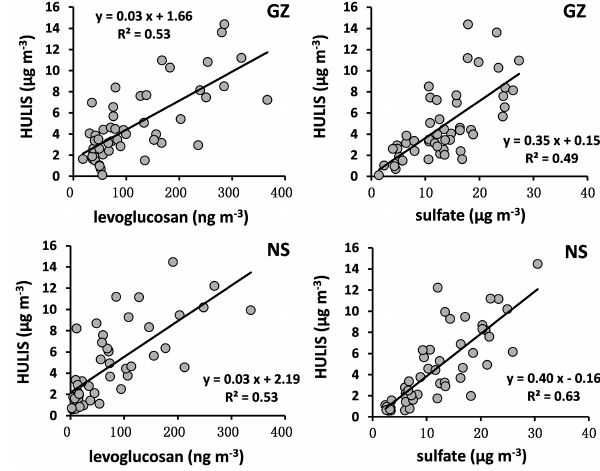
Figure 4. Correlation of HULIS with levoglucosan and